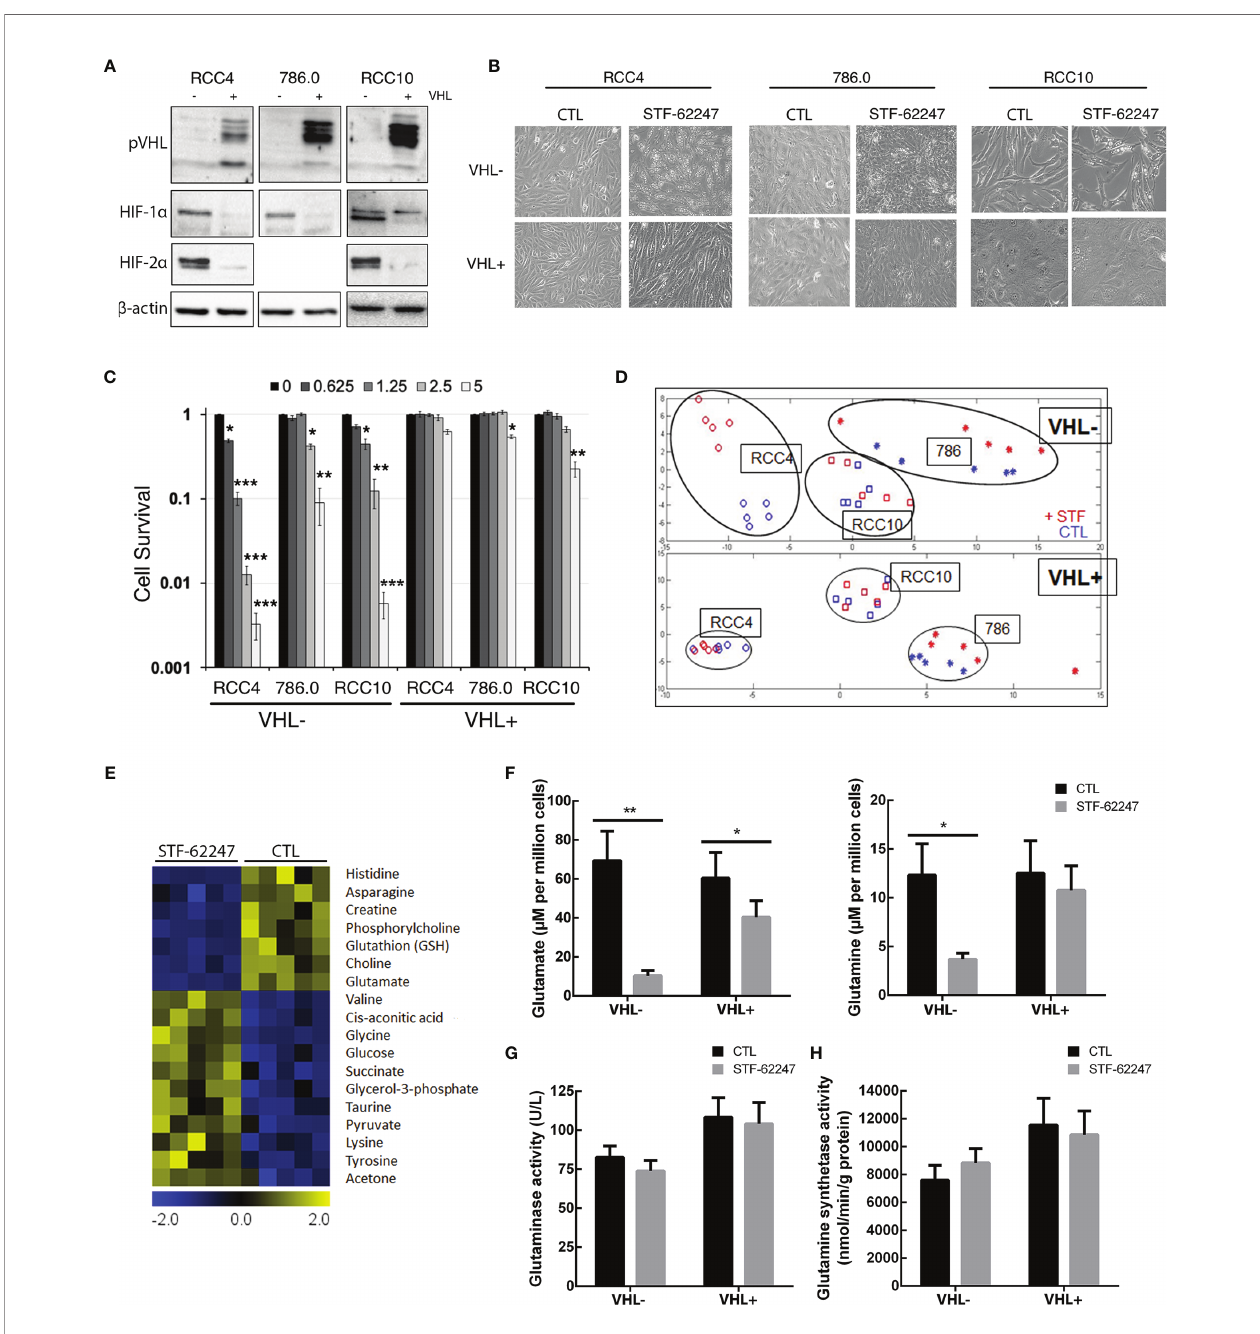
FIGURE 1 | Metabolic pro fi ling in renal cell carcinoma cell lines treated to STF-62247. (A) Immunoblot analysis of VHL- RCC cells (RCC4, 786.0 and RCC10) and their counterparts where VHL was reintroduced (indicated by the notation VHL+). Validation of our models was done by detecting pVHL and hypoxia-inducible factors (HIF-1 a and HIF-2 a ). (B) Inverted-light microscopy images of vacuolization in VHL- and VHL+ cell lines treated to STF-62247. (C) Cell survival was measured by clonogenic assay in VHL- and VHL+ cells. Cells were treated with doses of STF-62247 ranging from 0 to 5 µM. Results are normalized with their respective control (dose 0). Student ’ s t -tests were used to evaluate signi fi cant differences for each STF-62247 dose (N=3). (D) Principal component analysis (PCA) of 1 H NMR metabolic data from renal cell carcinoma cell lines. RCC4 cells were treated with STF-62247 at 1.25 m M for 24 hr and 786.0 and RCC10 cells at 2.5 m M for 48 hr (N=5). (E) Signi fi cance analysis of microarray (SAM) of differentially concentrated intracellular metabolites in RCC4 VHL- cells when treated to 1.25 µM STF-62247 (N=5). (F) Intracellular glutamine and glutamate measured by LC-MS in RCC4 VHL- and VHL+ treated with 1.25 µM STF-62247 for 24 hr (N=5). (G, H) Enzymatic activity of glutaminase (G) and glutamine synthetase (H) in RCC4 VHL- and VHL+ cells treated with 1.25 µM STF-62247 for 24 hr (N=3 and N=4 respectively). Results are presented as means and SEM of at least three independent experiments. Two-Way ANOVA followed by Tukey ’ s test was performed to assess signi fi cant differences in the results (F – H) . (*p < 0.05, **p < 0.01, ***p <